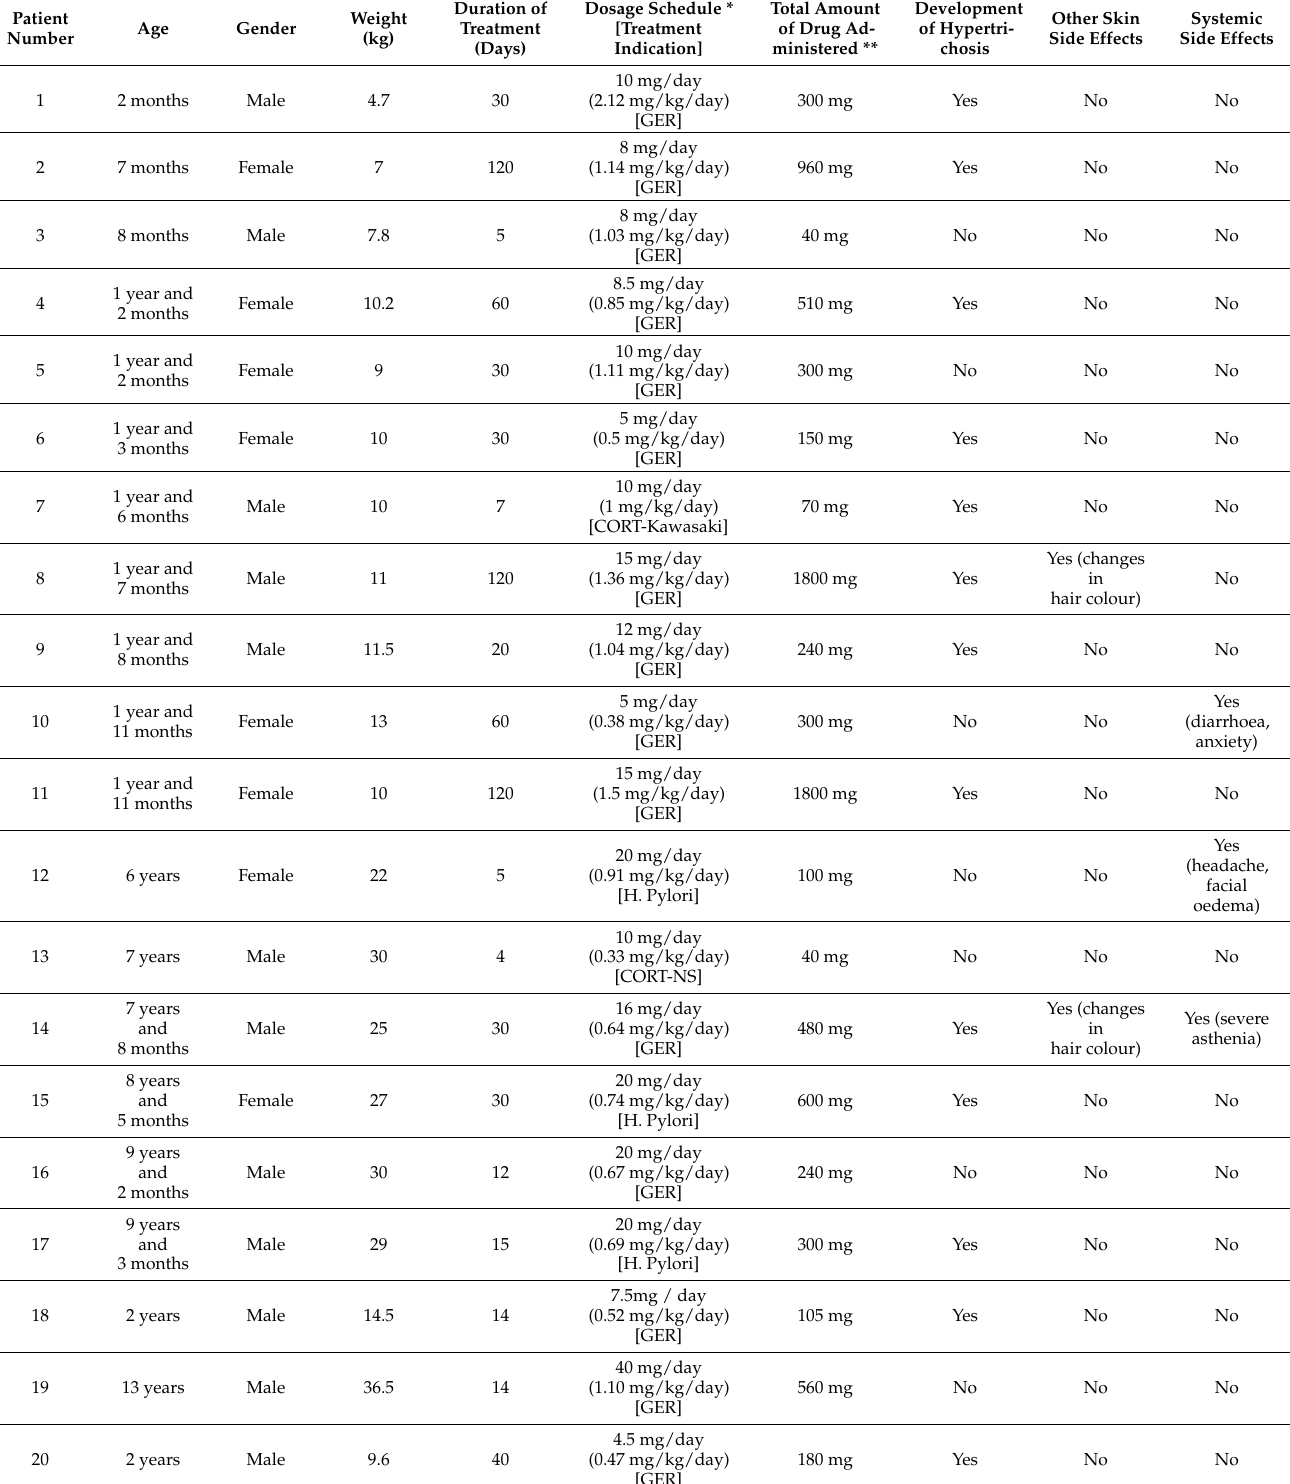
Table A1. Complete data about patient’s